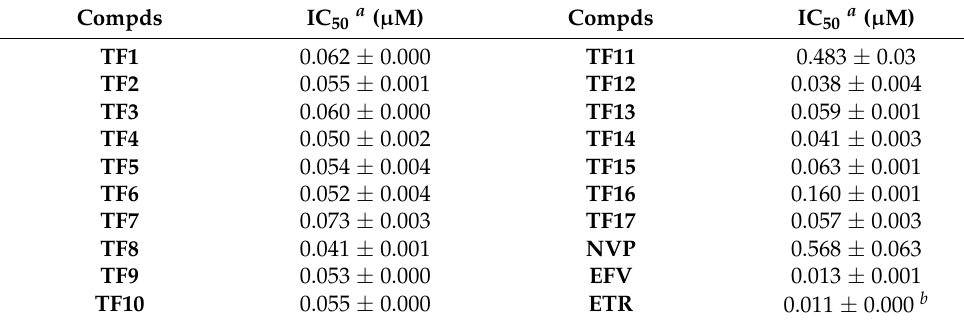
Table 4. The activity of TF1 - TF17 against HIV-1 WT RT. Compds